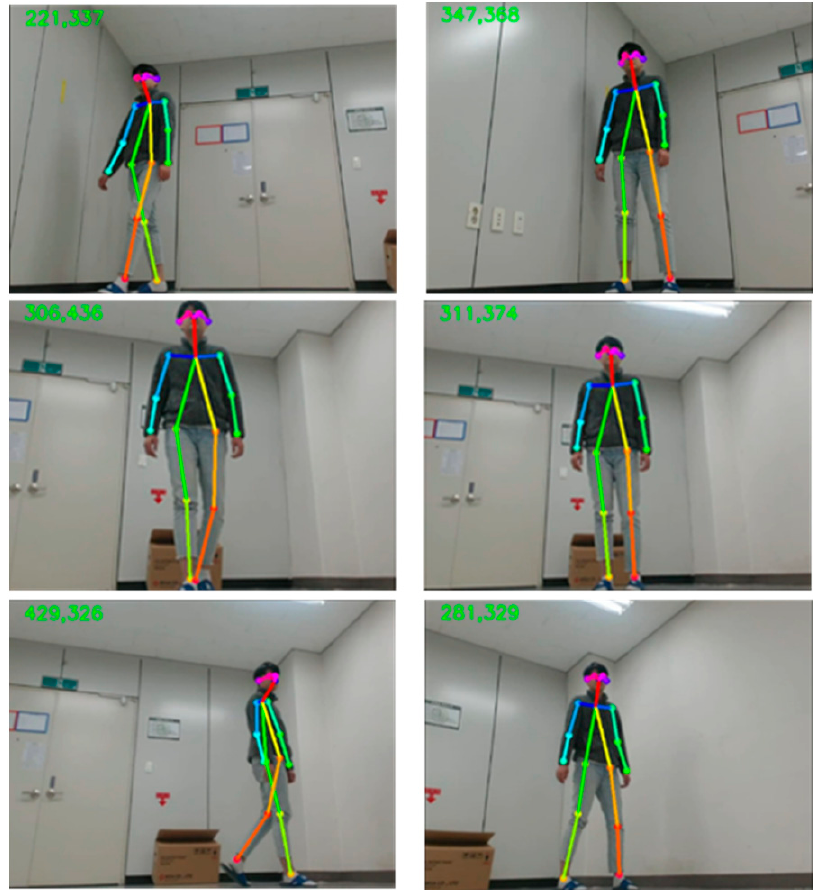
Figure 9. Tracking results during the movement.